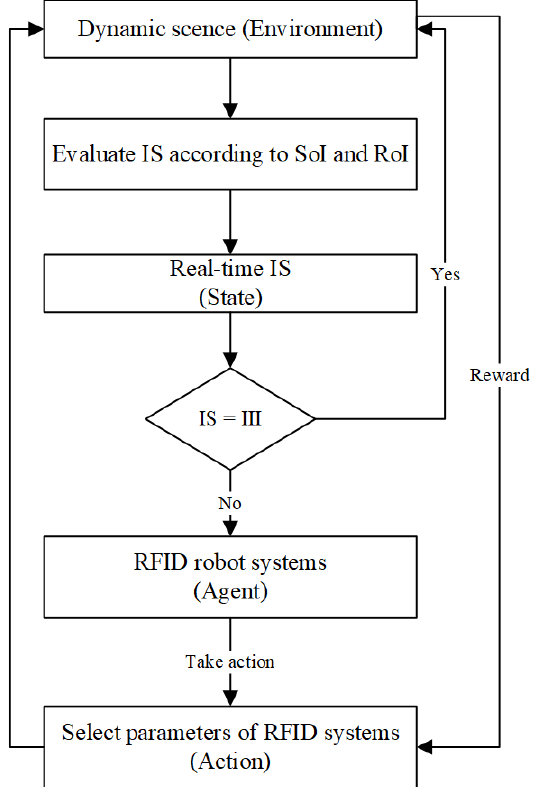
Figure 14. The model of adaptive control of parameters for RFID robot